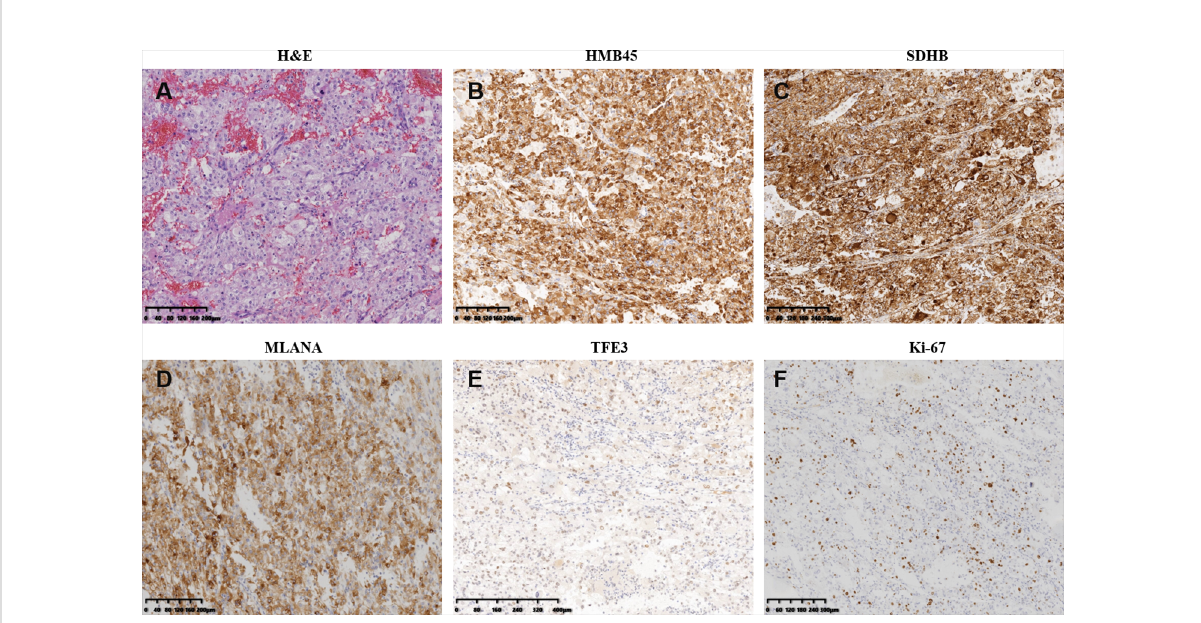
FIGURE 2 Pathological and immunohistochemistry features of the primary perivascular epithelioid cell tumor resected right kidney. (A) Hematoxylin – eosin staining of resection specimen. (B – F) Immunohistochemistry of select tumor markers: HMB45 (B) , SDHB (C) , MLANA (D) , TFE3 (E) , and Ki-67 (F) .